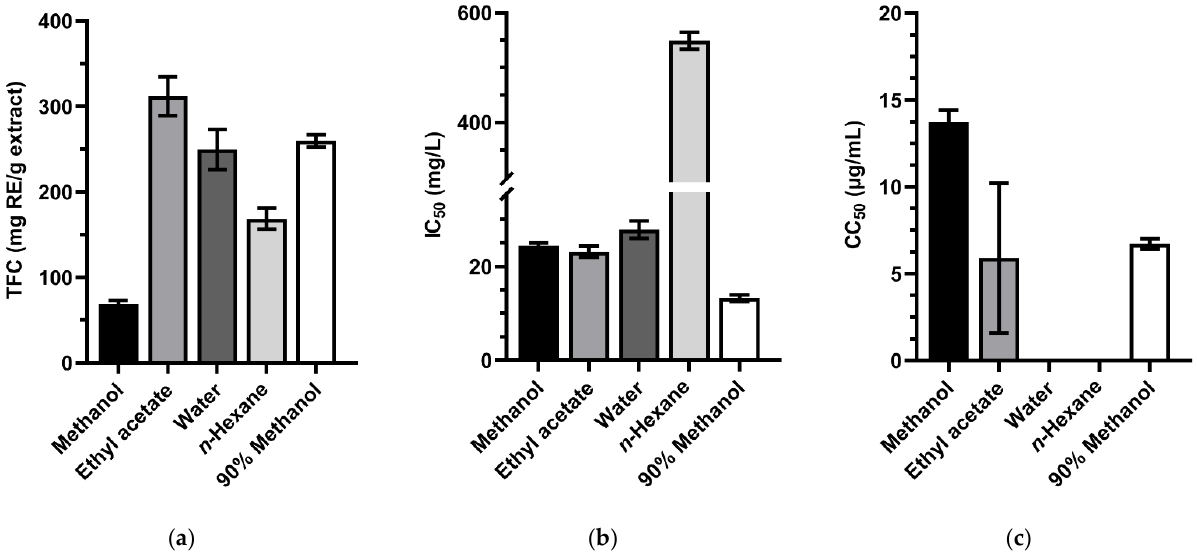
Figure 3. ( a ) Total flavonoids content, ( b ) the antioxidant activity in DPPH assay and ( c ) the cytotoxicity effect on Huh-7 HCC cells of Hyptis suaveolens leaves extracting in methanol, ethyl acetate, water, n -hexane, and 90% methanol. For panel ( c ), no bar is shown for the extracts that had a 50% cytotoxic concentration of more than 100 µg/mL. Values are presented as mean ± SD ( n = 3). Error bars show standard deviation.